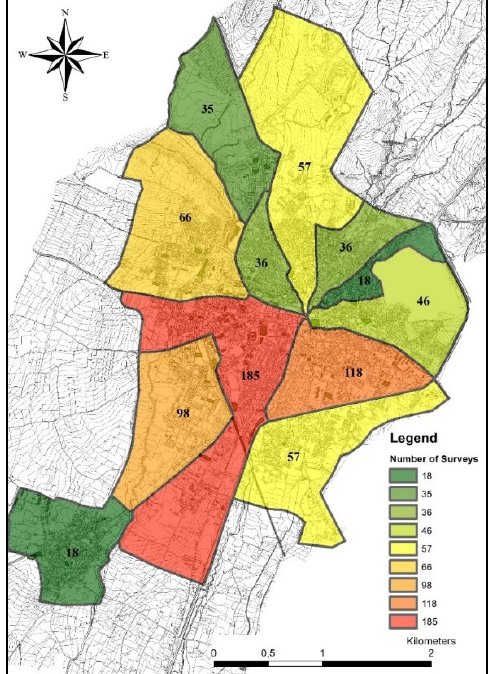
Figure 6. Number of Surveys per